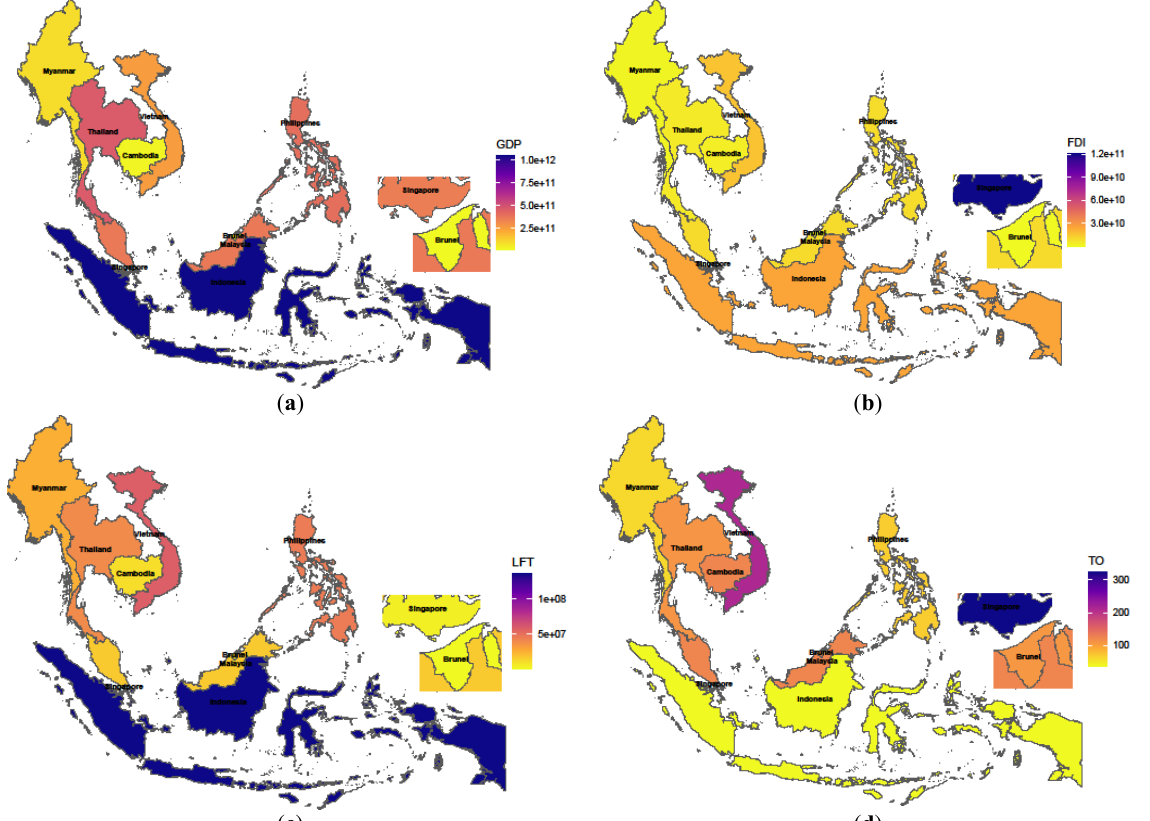
Fig. 3. Distribution map of variables in 2019: (a) GDP; (b) FDI; ( c ) LFT; ( d ) TO. Source: primary data processed with the R